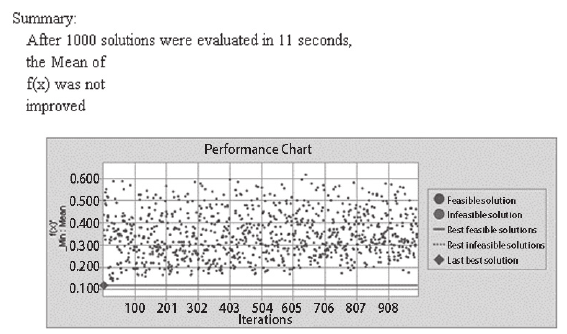
Fig. 11. Optimization